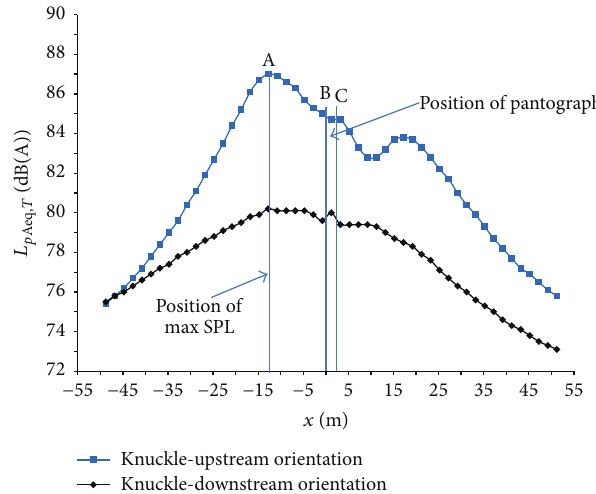
Figure 15: Comparison of the longitudinal SPL distribution for the two operation orientations.